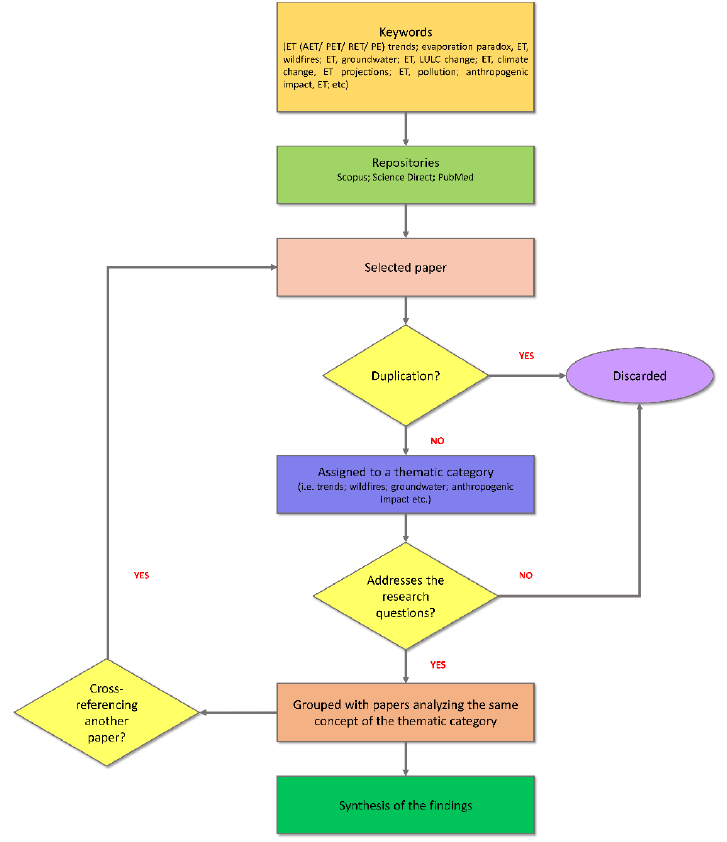
Figure 1. Flowchart of the review’s methodology.